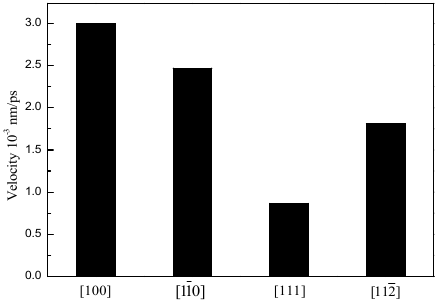
Figure 2. Growth rates of the simulated growths of silicon from melt along the different crystallographic directions.